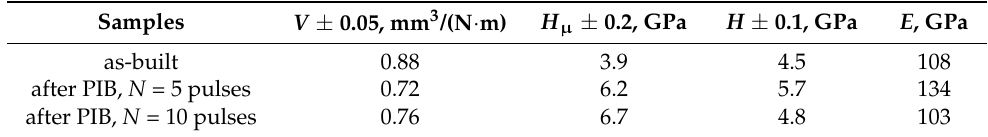
Figure 7. ( a ) Dependence of friction coefficient of the EBM Ti-6Al-4V alloy before and after PIB on distance; and wear scars for as-built sample ( b ), sample after PIB exposure (mode 1) ( c ), sample after PIB exposure (mode 2) ( d ). The average value of the friction coefficient of as-built samples of EBM Ti-6Al-4V alloy before PIB exposure was 0.49. For samples modified by PIB ( N = 5 pulses), a decrease in the friction coefficient from 0.49 to 0.43 at distances of up to 2 m is observed; with further tests, the average values of the friction coefficient increase to 0.5. A feature of the samples after exposure to 10 pulses of PIB is a monotonic growth in the values of the friction coefficient with the rise in track length. Table 1. Wear rate ( V ), microhardness ( H µ ), nanohardness ( H ), and Young’s modulus ( E ) of the EBM Ti-6Al-4V alloy samples before and after PIB